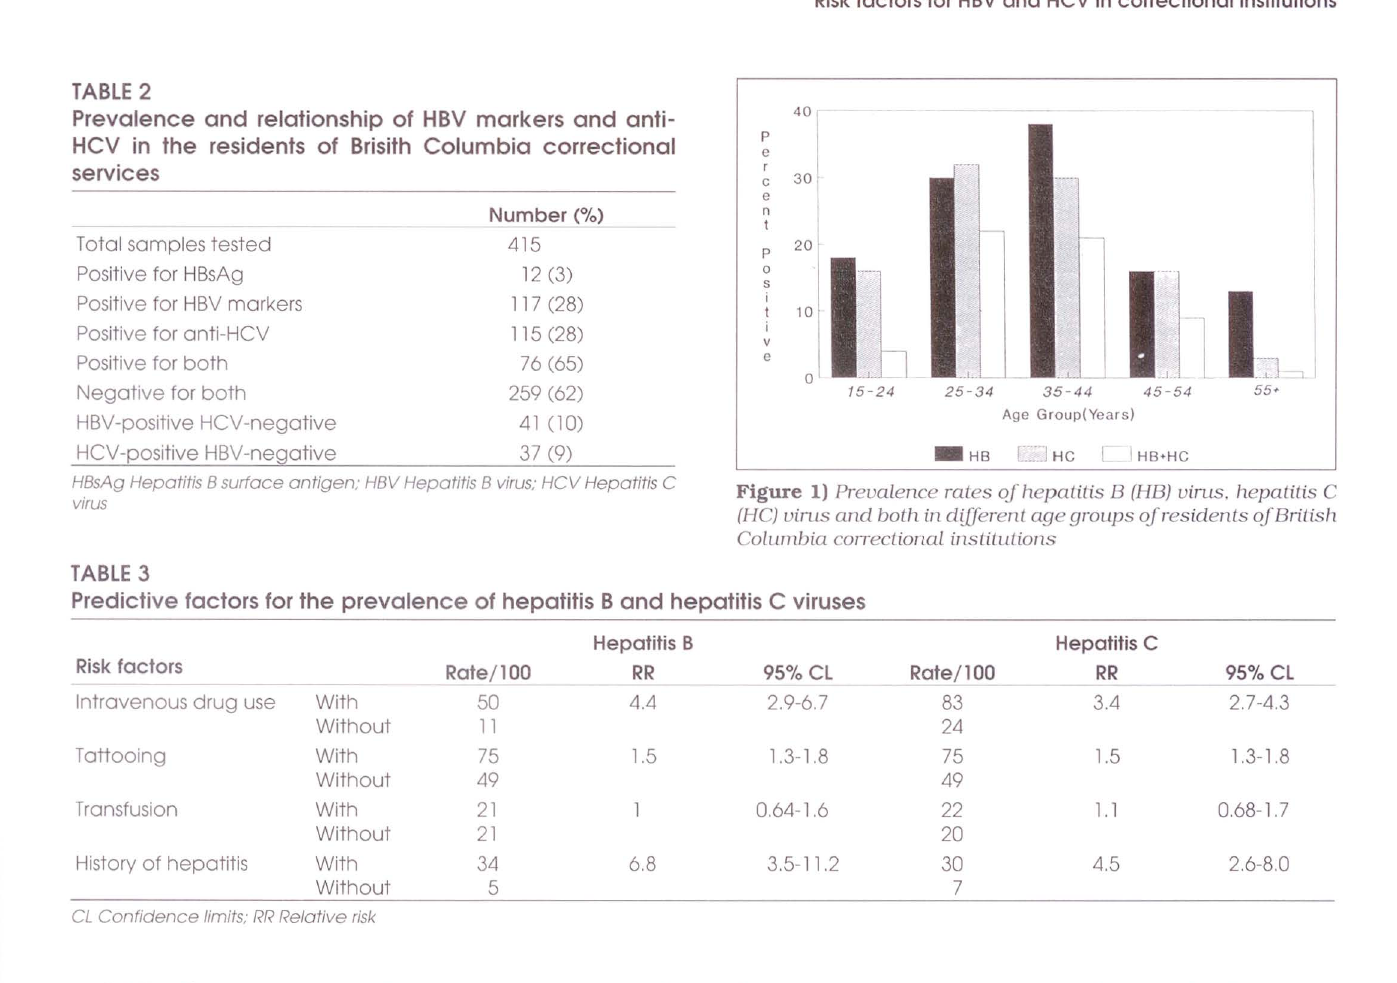
Prevalence and relationship of HBV markers and anti HCV in the residents of Brisith Columbia correctional